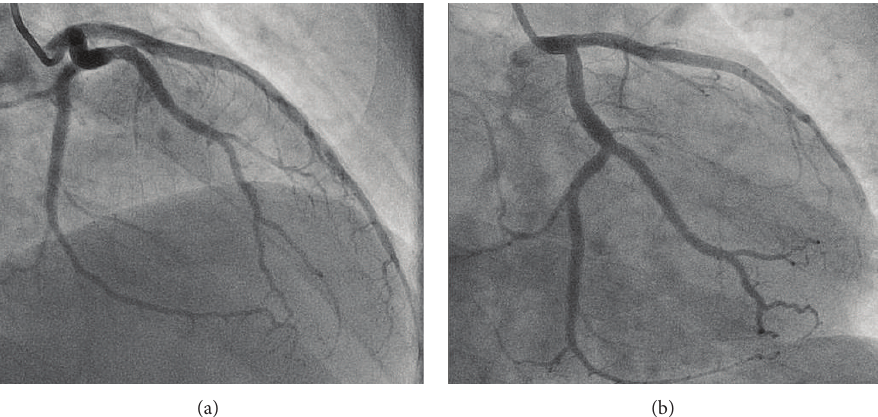
Figure 2: LCA, with the “short” LAD artery coursing through the proximal part of the AIVS. (a) RAO caudal view. (b) PA caudal view. LCA, left coronary artery; LAD, left anterior descending artery; AIVS, anterior interventricular sulcus; RAO, right anterior oblique; PA, posterior- anterior.